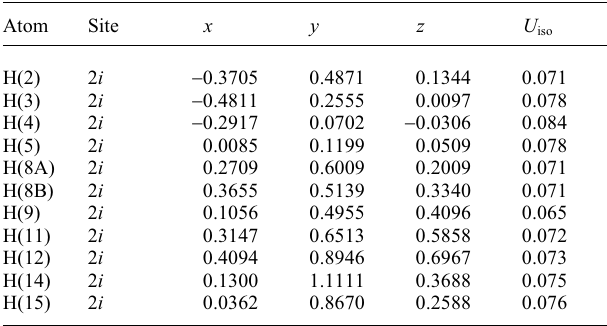
Table 2. Atomic coordinates and displacement parameters (in Å 2 )